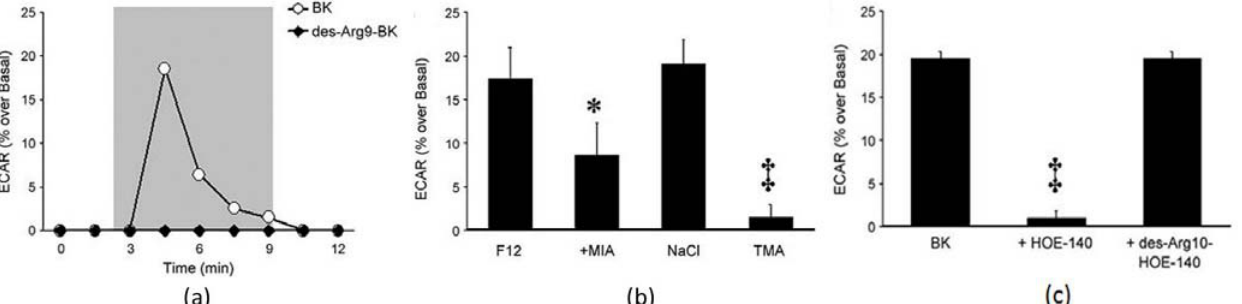
Figure 19. ECAR of HEK293 cells under stimulation of BK. ( a ) ECAR measurements were monitored. BK (white circles) stimulates ECAR, whereas the BK B receptor agonist 1 des-Agr9-BK (dark circles) does not. Cells were exposed to perfusate-containing drug during the time span encompassed by the gray box; ( b ) ECAR stimulated by 10 − 6 M of BK in various buffers, including Ham’s F12 medium, without and with 10 − 5 M MIA, a balanced salt solution containing NaCl or TMA substituted mM per mM for sodium. * P < 0.05 vs . BK alone; zP < 0.01 vs . BK in balanced salt solution with NaCl; ( c ) Effects of BK B 2 (HOE-140) and BK B (des-Arg 10 -HOE-140) receptor antagonists on BK-stimulated 1 ECAR. Antagonists (10 − 5 M) were added 30 min prior to addition of BK. All experiments were performed at least 4 times. zP < 0.01 vs . BK alone. Error bars in (b) and (c) represent the S.E.M. (Reprinted from [115]. © 2009, with permission from